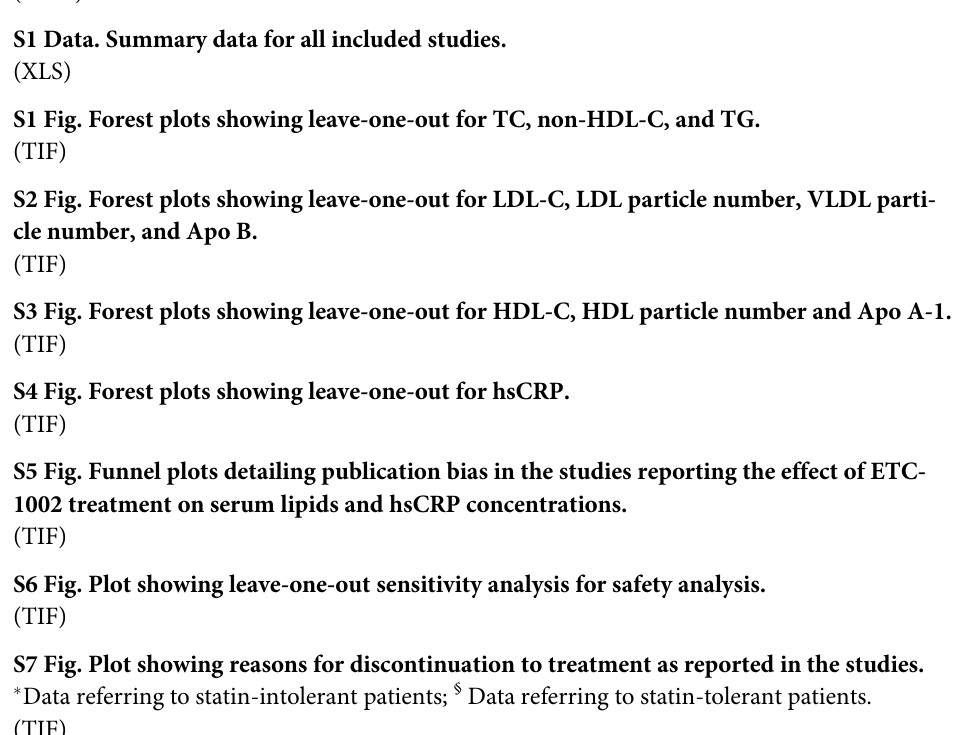
S8 Fig. Funnel plot detailing publication bias in the safety analysis. S1 Table. Meta-analysis’ findings after excluding the CLEAR Harmony study. S2 Table. Begg’s rank correlation nor Egger’s linear regression tests. S3 Table. Classic fail-safe N results for the efficacy analyses. S4 Table. Adverse events occurred in at least 2 clinical trials. AEs = Adverse events. S5 Table. Reasons of discontinuation to treatments as reported by the studies. S6 Table. Classic fail-safe N results for the safety